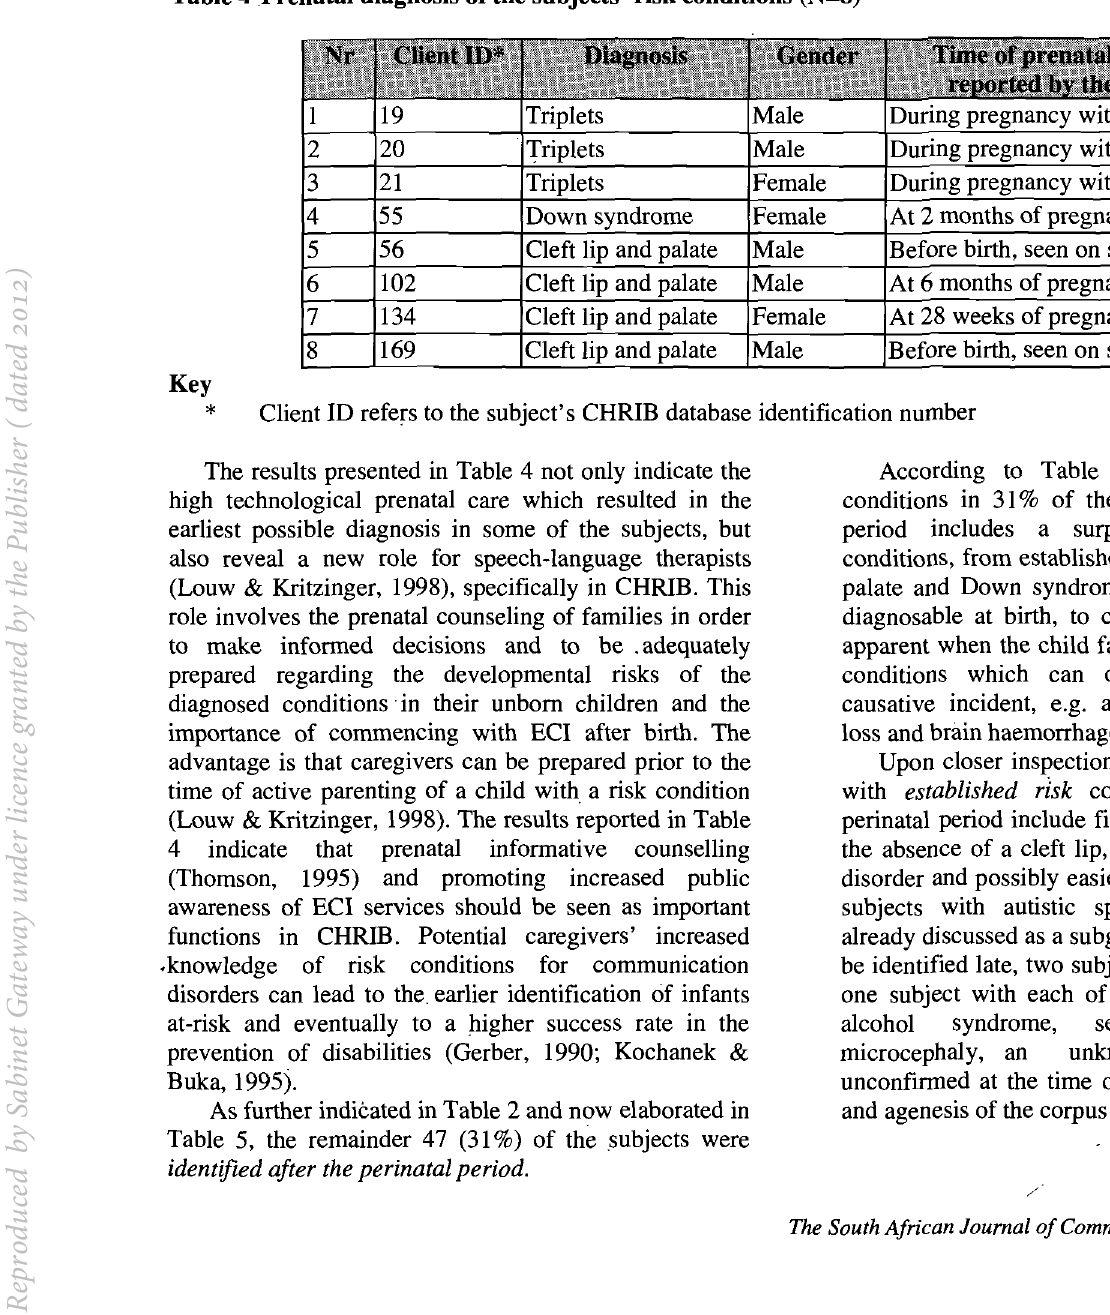
Table 4 Prenatal diagnosis of the subjects' risk conditions